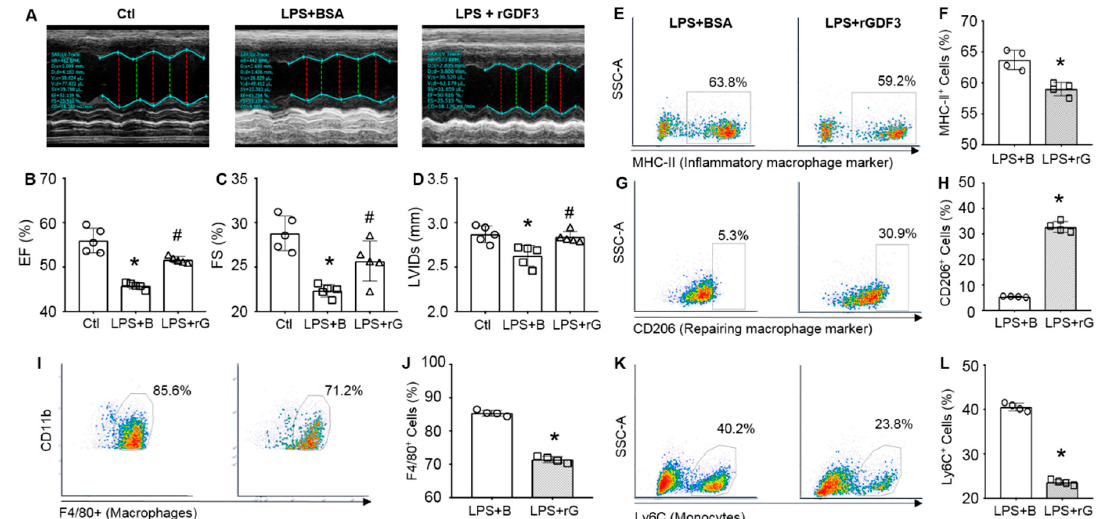
Figure 6. Administration of rGDF3 to LPS-mice improves cardiac function and promotes cardiac macrophage M2 phenotype. WT mice received recombinant GDF3 protein (I.P., 10 µ g / kg BW) 12 h prior to LPS injection (I.P., 10mg / kg BW), 12 h later cardiac function was measured by echocardiograph. ( A ) Representative M-mode echocardiography recordings for three groups, and ( B ) left ventricular ejection fraction (EF %), ( C ) fractional shortening (FS %) and ( D ) left ventricular internal dimension at end-systolic (LVIDs) were calculated (*, p < 0.05 vs. Ctl; #, p < 0.05 vs. LPS + B; n = 5). Cardiac cells were stained with antibodies to ( E ) MHC-II, ( G ) CD206, ( I ) F4 / 80 plus CD11b, ( K ) Ly6C for flow cytometry analysis and their respective quantification results are shown in ( F , H , J , L ). (*, p < 0.05; n = 4). Similar results were obtained in other two independent experiments.